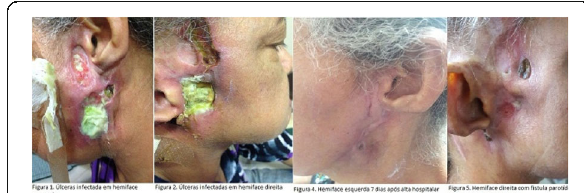
Fig. 1 (abstract P112). Ulcera cutânea numa paciente com Lupus Discoide associado a